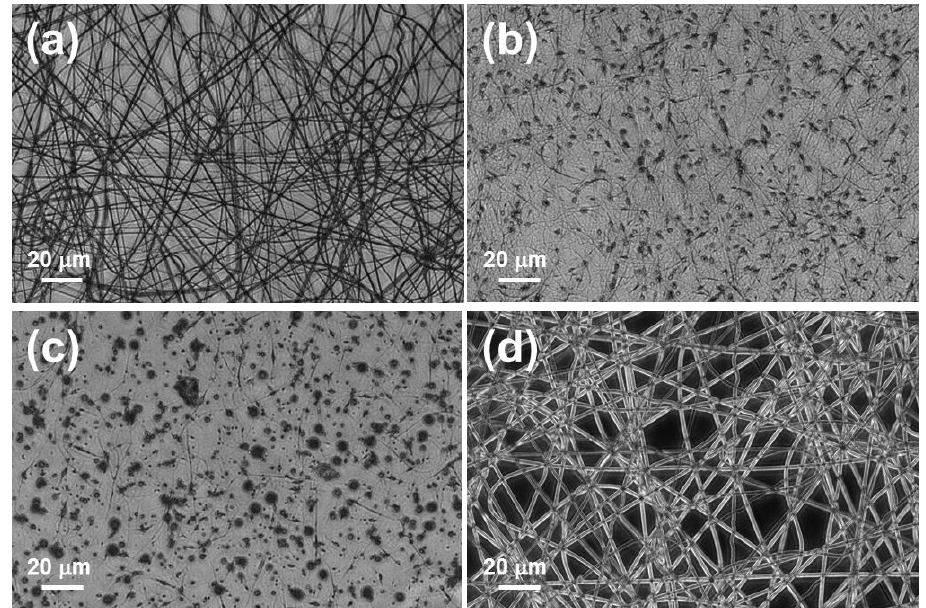
Figure 3. Optical microscopy micrographs of ( a ) unloaded PE44, ( b ) PE44/GA-S1, ( c ) PE44/GA-S2 and ( d ) PE44/GA-L electrospun nanofibers. Table 1. Average diameter ( D ), root-mean-square roughness (RMS R q ), temperatures for 50% and 70% weight loss (T 50% and T 70% , respectively), maximum temperature (T max ) and contact angle ( θ ).